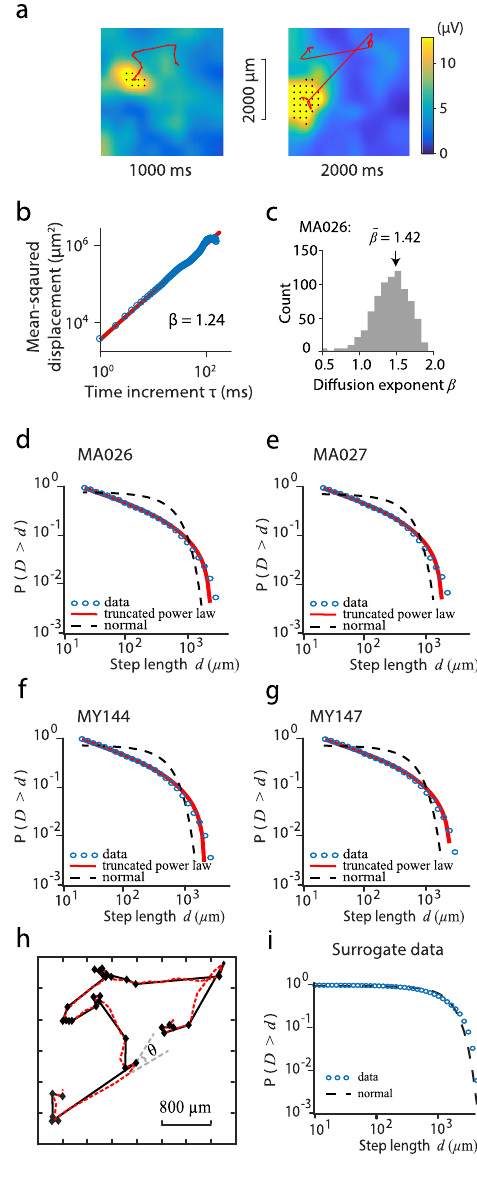
Fig. 3 Spatiotemporal dynamics of gamma burst patterns. a Snapshots of gamma amplitudes at two timepoints (case MA027; recordings separated by 1 s). Detected bursts are indicated by black dots. Red lines show the trajectories of the center of mass positions of the burst pattern over the previous 100 ms (left) and 300 ms (right). b Mean square displacement (MSD) of the trajectory of a typical burst pattern as a function of time increment. Red line indicates a fi tted power function of MSD, MSD τ ð Þ / τ β , with diffusion exponent β = 1.24. c Distribution of diffusion exponent β for gamma bursts of animal MA026 (5 min); mean value is 1.42. d Complementary cumulative probability distribution (CCPD) of the step lengths (1D model) of MA026 (blue dots). Red line indicates a fi tted truncated power distribution with λ = 1.32. For comparison, a normal distribution (black dashed line) with mean μ ¼ 0 : 31 ´ 10 3 and standard deviation σ = 0 : 52 ´ 10 3 is shown. e As d , case MA027, λ = 1.33, μ = 0 : 26 ´ 10 3 , σ = 0 : 43 ´ 10 3 . f As e , case MY144, λ = 1.33, μ = 0 : 29 ´ 10 3 , σ = 0 : 48 ´ 10 3 g As f , case MY147, λ = 1.30, μ = 0 : 32 ´ 10 3 , σ = 0 : 52 ´ 10 3 is shown. h The angle model used to extract step length from traces ( θ ¼ 40 (cid:3) ). Red dashed lines show the trajectories of the center of mass positions of a gamma burst pattern. An example change of angle θ is shown. The step lengths (black lines) are calculated as the distance between turning points (black dots) where the angle θ is >40 (cid:3) . i